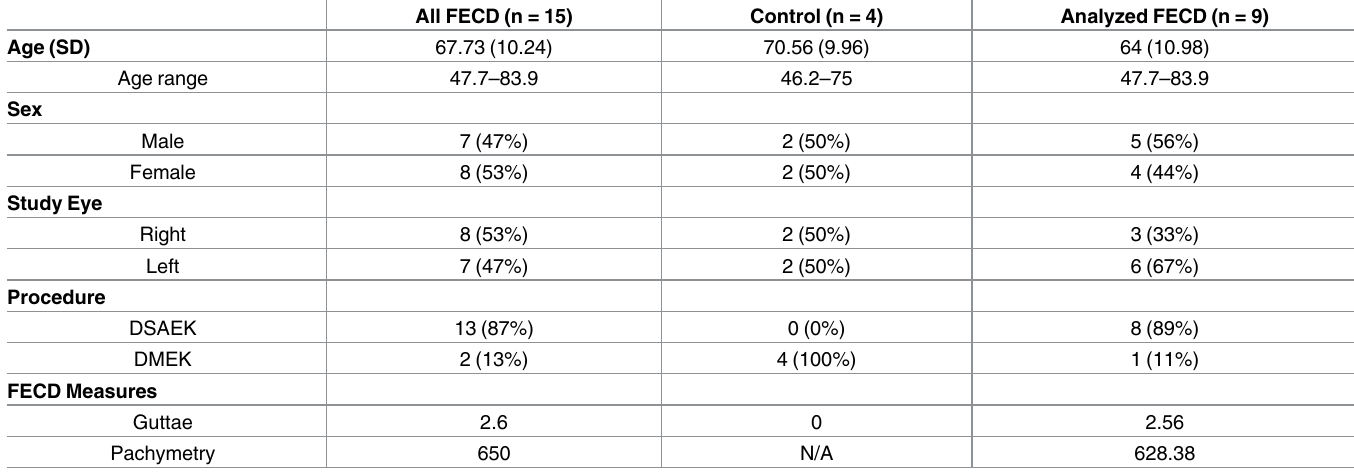
Table 1. Demographics of study participants for genome-wide DNA methylation